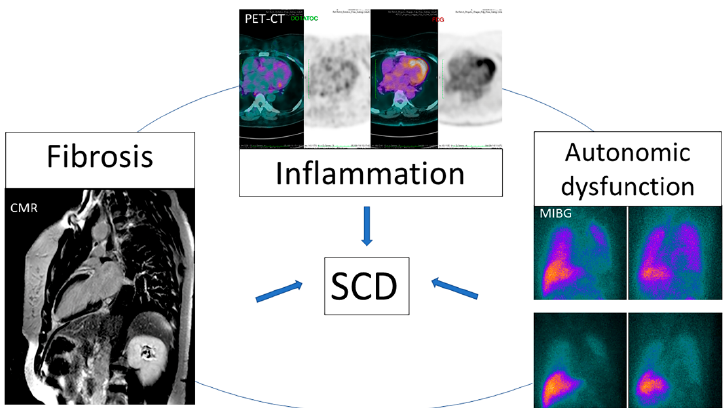
Figure 9. New imaging modalities can detect abnormalities involved in the genesis of ventricular arrythmia. SCD: Sudden cardiac death.